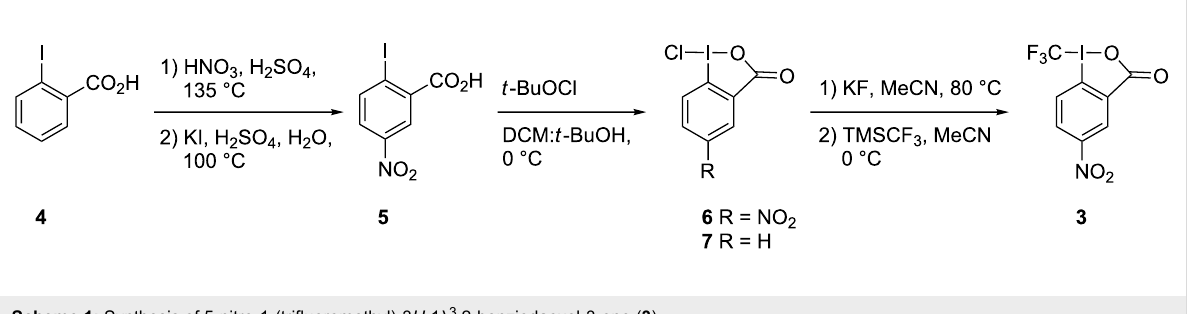
Scheme 1: Synthesis of 5-nitro-1-(trifluoromethyl)-3 H -1 λ 3 ,2-benziodaoxol-3-one ( 3 ).